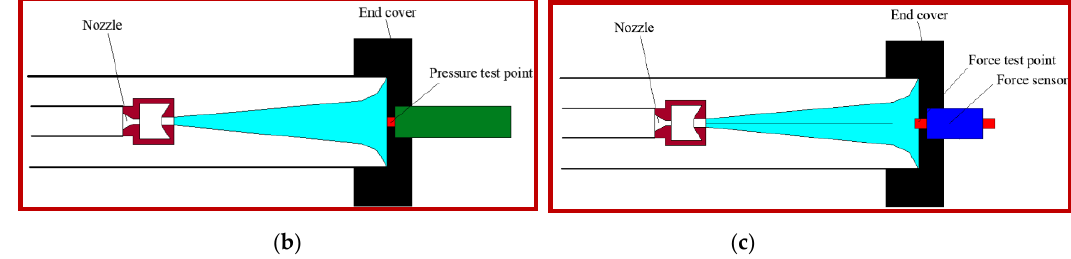
Figure 3. ( a ) Schematic diagram of the experimental system and ( b ) enlargement of the red box containing the maximum pressure measurement point ( c ) enlargement of the red box containing the force measurement point.